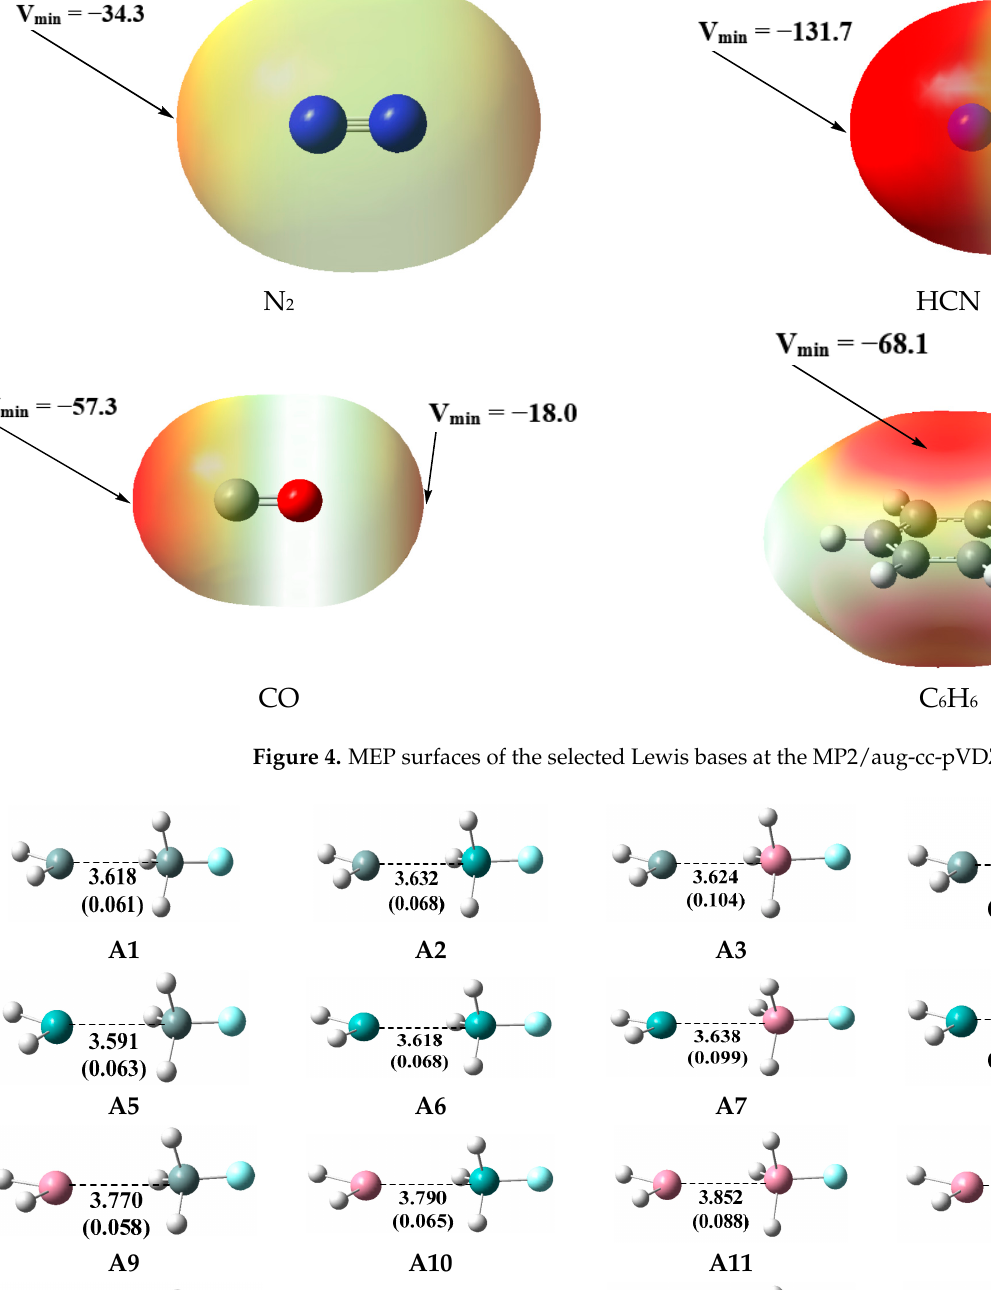
Table 1. Binding distance at MP2/aug-cc-pVDZ and MP2/aug-cc-pVTZ (in parentheses) levels ( R ,